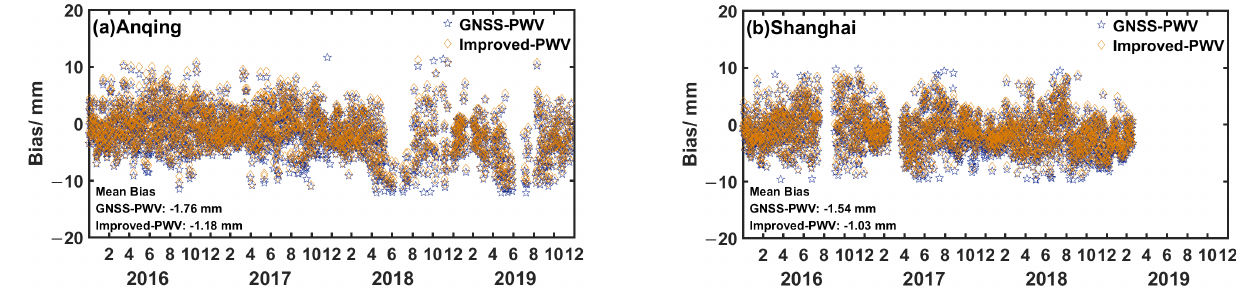
Figure 10. The bias of GNSS-PWV and improved-PWV in Anqing ( a ) and Shanghai ( b ) during the 2016–2019 period.